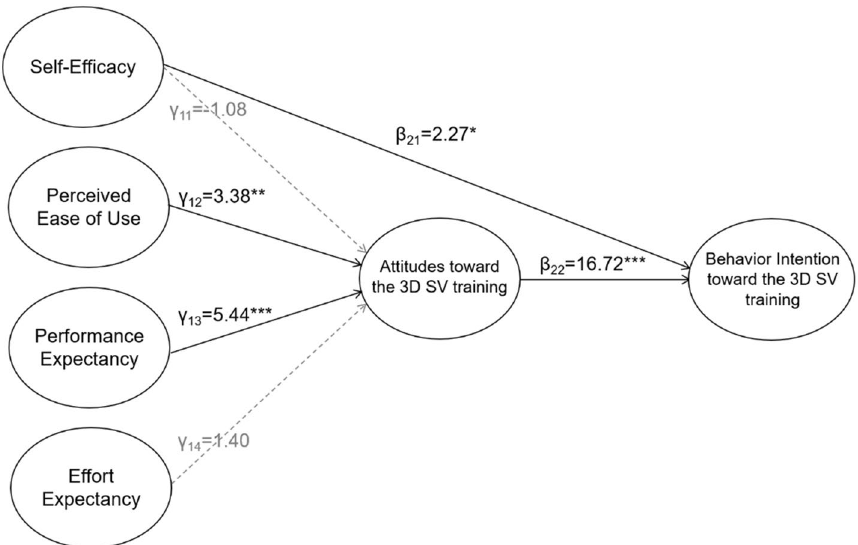
Fig. 3 Structural equation model for the main effects. *z-value (two-tailed) (p 0.01), ***z-value ≤